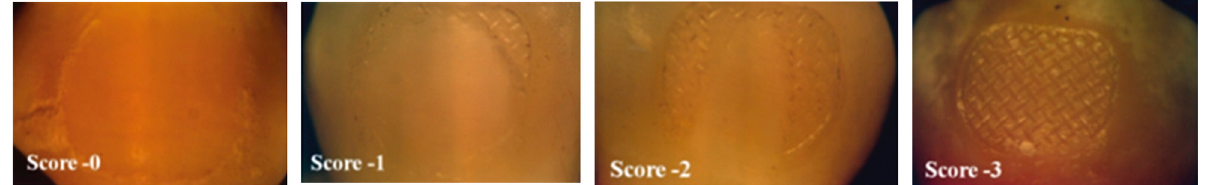
Figure 2. ARI score